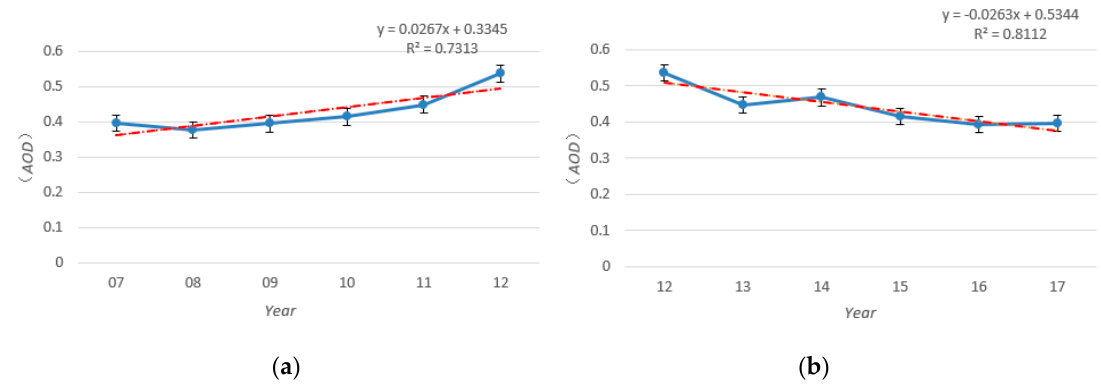
Figure 5. Annual data chart.